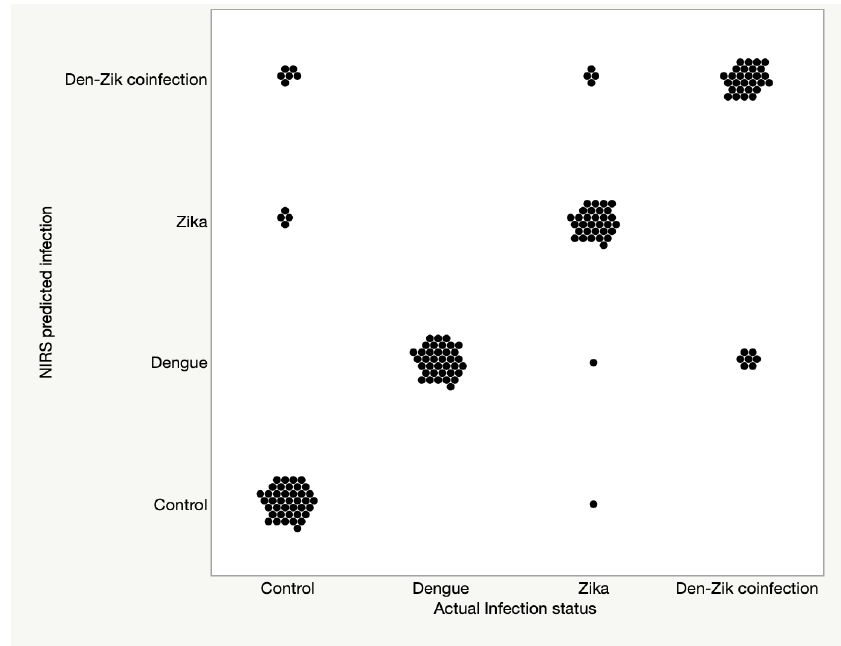
Figure 4. The predictive accuracy of NIRS for samples that were used to test the ANN model.